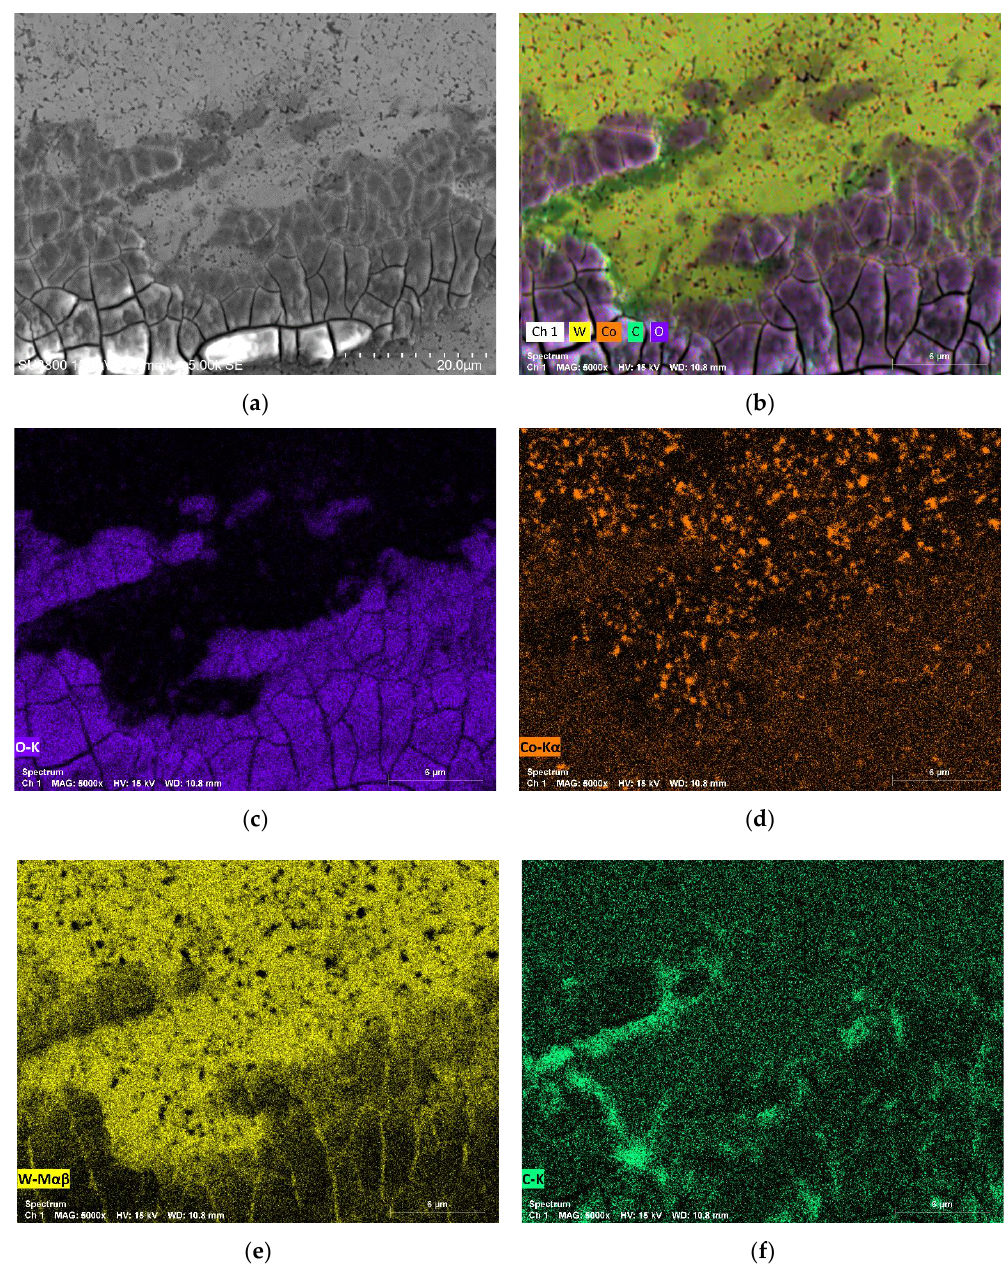
Figure 16. SEM micrograph and EDS analysis for the system WC-Co/Al 2 O 3 showing the chemical composition in the border between the wear track with oxides formation and the unworn surface: ( a ) SEM with 5kx magnification; ( b ) Map with the spectrum of all chemical elements; ( c ) Spectrum of Oxygen; ( d ) Spectrum of Cobalt; ( e ) Spectrum of Tungsten; ( f ) Spectrum of Carbon. The reason behind the greater stability exhibited by WC-Co’s friction curves and the lowest wear rate coefficient observed for the WC-Co/Al 2 O 3 composite may be related